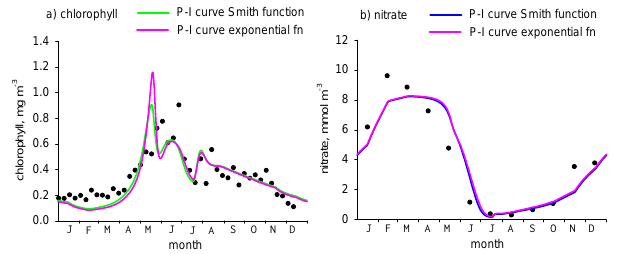
Figure 16. Simulations for station BIOTRANS showing sensitiv- ity to choice of P - I curve: (a) Smith function (standard run), (b) exponential function.